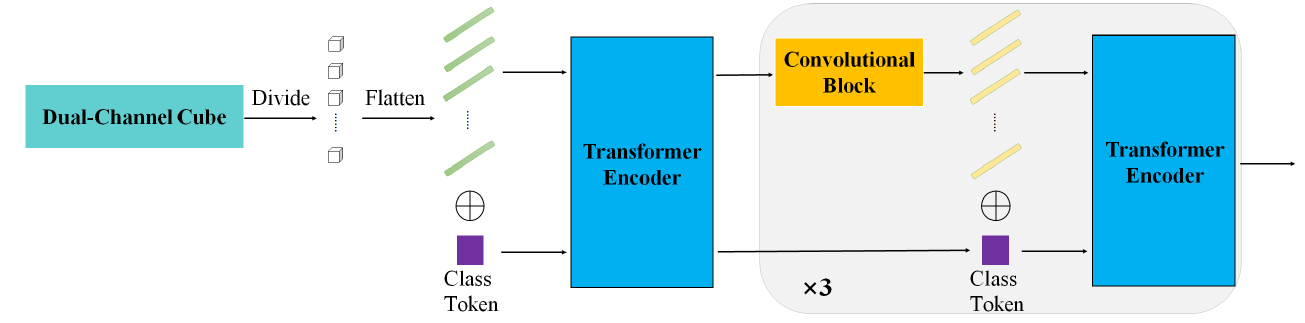
Figure 5. The Fusion Block that learns the class token to obtain the classification